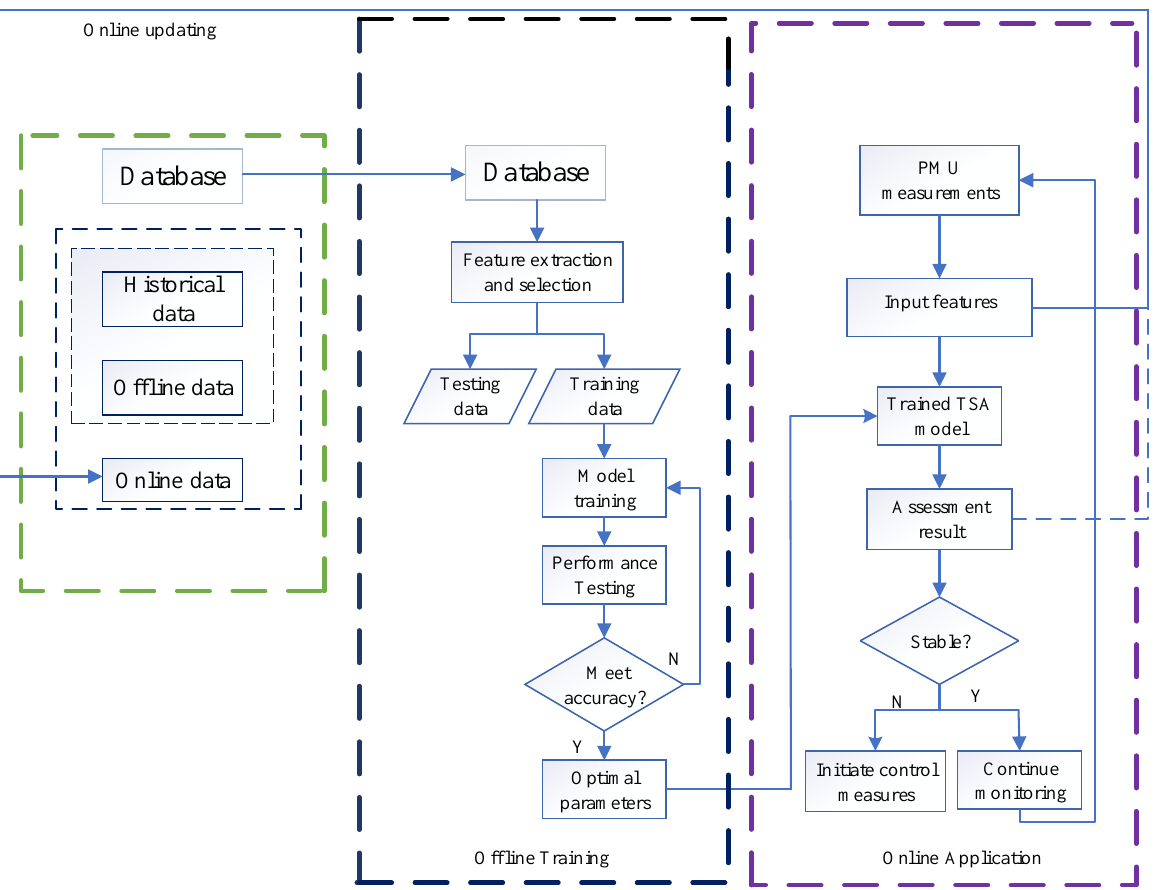
Figure 3. Flowchart of a typical data-driven transient stability assessment method.